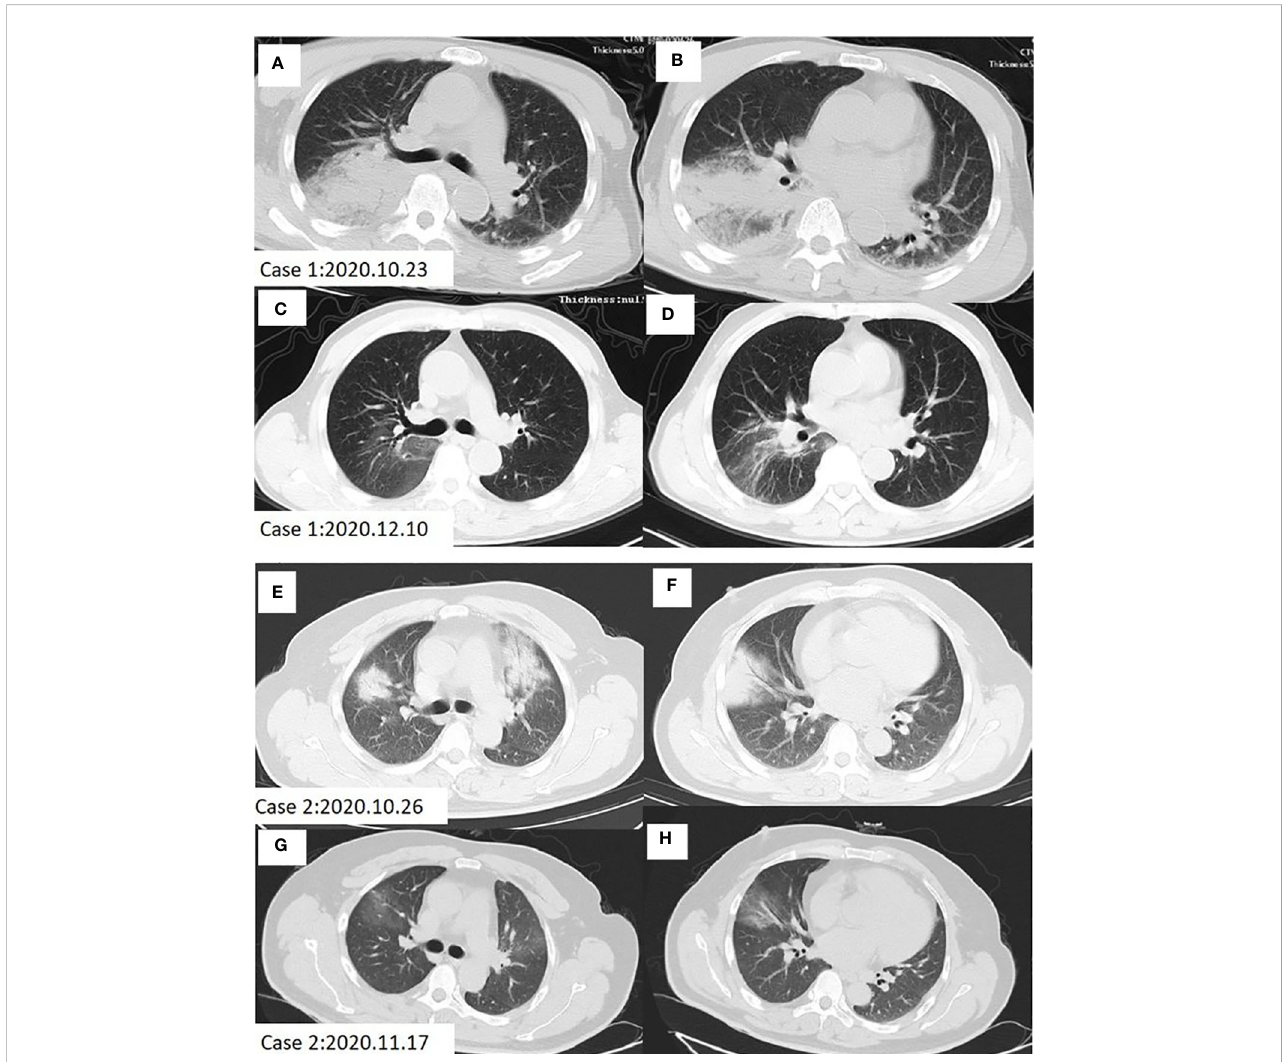
FIGURE 1 Chest CT scan of Case 1 and Case 2 before and after treatment. (A, B) Patchy in fi ltration and consolidation of both lungs, especially in the right lung in case 1 before treatment. (C, D) Lung shadow absorption after treatment in case 1. (E, F) Patchy high-density shade was seen in the anterior segment of the upper lobe, median lobe and the basal segment of the inferior lobe in the right lung, as well as the anterior segment of the upper lobe in the left lung of case 2 before treatment. (G, H) Lung shadow absorption after treatment in case